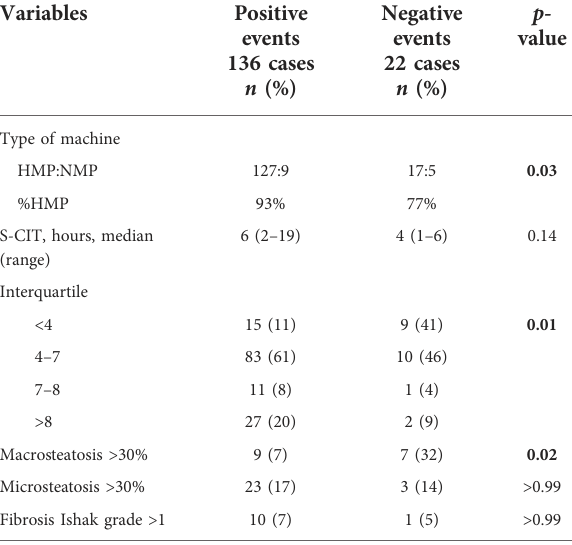
TABLE 2 Univariate analysis of graft histology features, type of machine perfusion adopted, and S-CIT for the negative events.